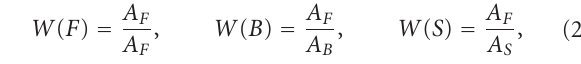
than the regions F and B . The regional weighting results in a subtitle color which is more opposite to the S region rather than F and B